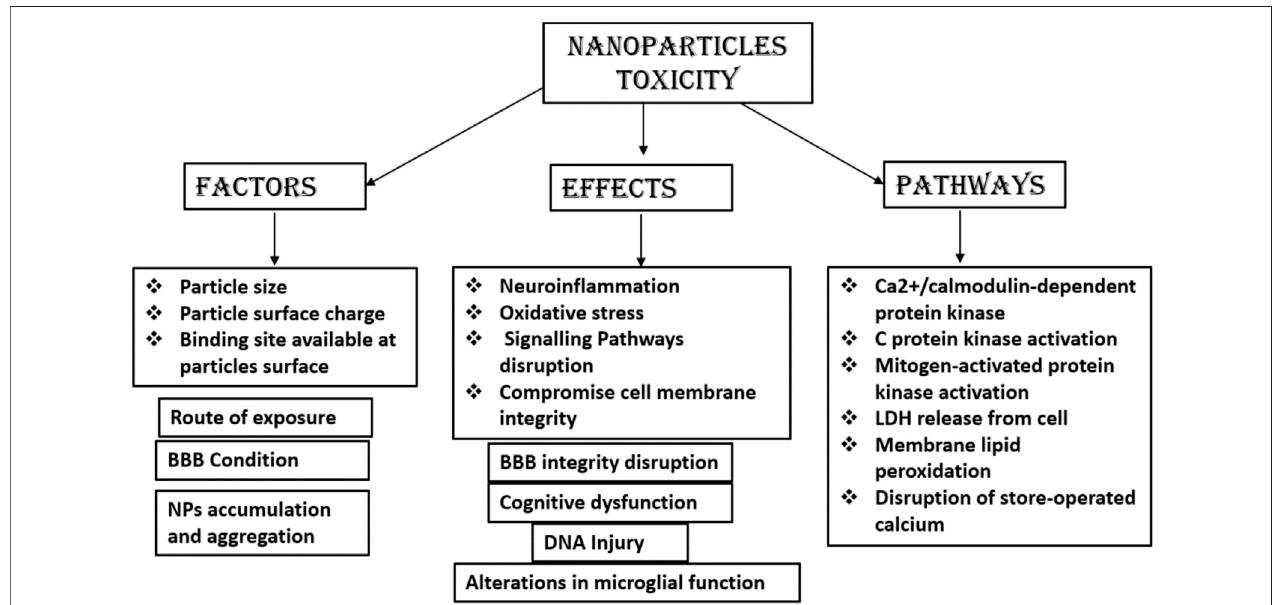
FIGURE 10 | Neurotoxic effects, pathways, and factors of NPs. NPs, nanoparticles.